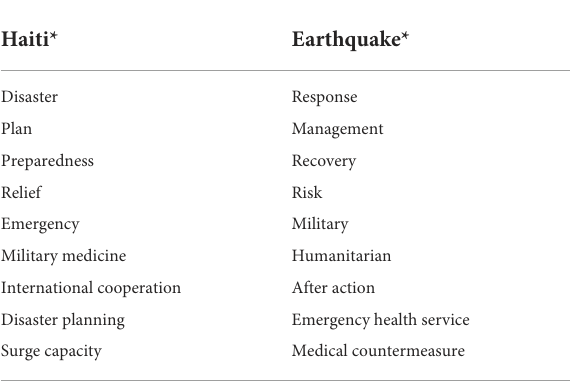
TABLE 1 Search terms